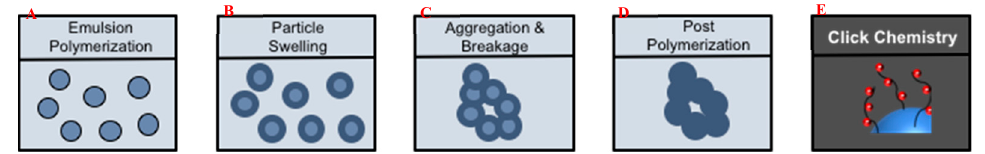
Figure 1. Sketch of the reactive gelation process towards functionalized macroporous polymeric scaffolds. ( A ) core-shell nanoparticle synthesis by emulsion polymerization; ( B ) swelling of the softer shell with crosslinker divinyl benzene (DVB) and initiator 2,2’-azobis(2-methylpropionitrile) (AIBN); ( C ) aggregation by applying high shear rates; ( D ) post-polymerization at 70 °C; ( E ) surface modification by click chemistry.